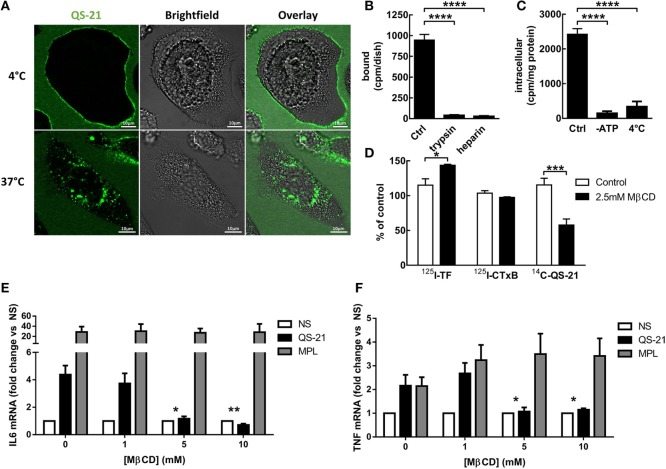
QS-21 is internalized by cholesterol-dependent endocytosis. (A)
Imaging: THP-1 cells were incubated with 10 µg/ml BODIPY-QS-21 for 1 h at either 4°C or 37°C, and fluorescence was visualized by vital confocal microscopy. (B)
Surface stripping: THP-1 cells (n = 3) were incubated at 4°C for 1 h with 10 µg/ml 14C-QS-21, then extensively washed (Ctrl) or further stripped at 4°C by trypsin or heparin sulfate. (C)
Endocytosis: Control or ATP-depleted THP-1 (n = 3) cells were incubated at 37°C for 4 h with 10 µg/ml 14C-QS-21, then stripped by trypsin as at (B). Parallel cells were incubated at 4°C. Statistical significance was determined by a one-way ANOVA followed by Tukey’s multiple comparisons test. (D)
Cholesterol dependence: THP-1 cells (n = 2–3) were cholesterol depleted or not by treatment with 2.5 mM methyl-β-cyclodextrin (MβCD) for 4 h, extensively washed, then incubated with 14C-QS-21 for 1 h or 125I-transferrin or 125I-cholera toxin/B subunit (CTxB) for 15 min, surface-stripped by trypsin and counted. Statistical significance was determined by a two-way ANOVA followed by Sidak’s multiple comparisons test. (E,F) moDCs (n = 8) were treated with the indicated concentration of MβCD for 1 h, extensively washed and stimulated with QS-21 or MPL for 4 h. IL-6 (E) and TNF (F) mRNA abundance was measured by qPCR and normalized to β-actin expression. Statistical significance was determined by a Wilcoxon matched-pairs signed-rank test. The asterisks depict significant differences between 5–10 mM MβCD and 0 mM MβCD for QS-21 stimulated cells.